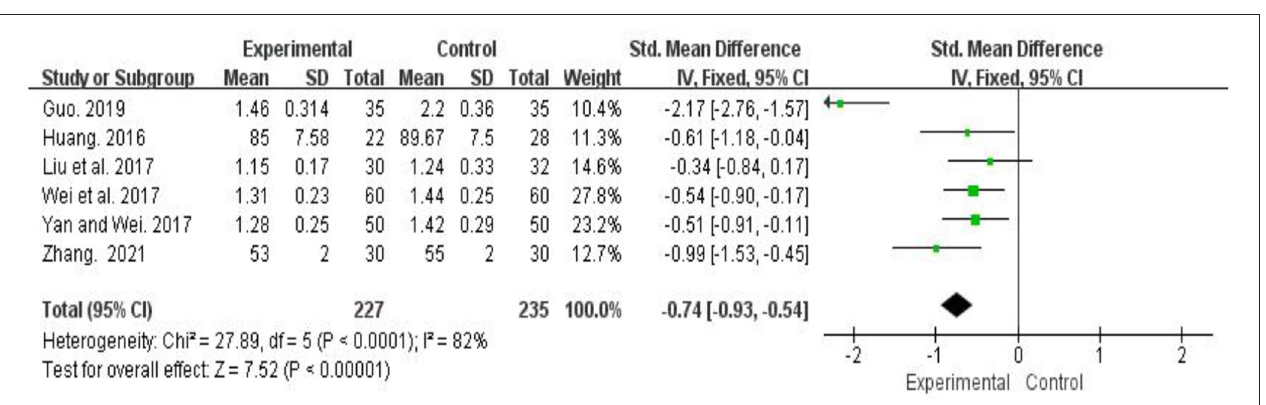
FIGURE 4 | Meta-analysis of traditional fitness exercises on anxiety among college students.